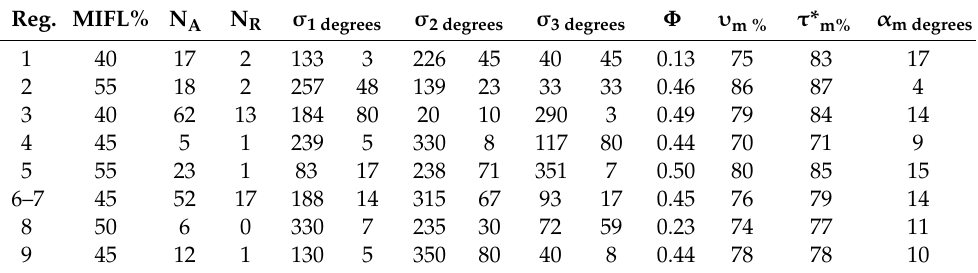
Table 1. Results of inversions for nine tectonic regimes based on the direct inversion method [4] with additional refining process [13]. Reg. = reference number of regime, also referred to in Table 2. MIFL = the control parameter, indicates the minimum individual fit level finally retained (see the term = number of fault planes found acceptable at this level ω in [13] for detailed discussion of MIFL). N A of fit. N R = number of fault planes rejected. The stress tensor obtained is characterized by the trends and plunges of the three principal stress axes, σ 1 , σ 2, and σ 3 , and by Φ = ( σ 2 − σ 3 ) / ( σ 1 − σ 3 ), the ratio of the principal stress di ff erences where 0 ≤ Φ 13 [2]. υ m = average value of the main estimator [4], τ * m = ratio of the average shear stress to the maximum shear stress. α m = average value of the calculated shear-actual slip angle.